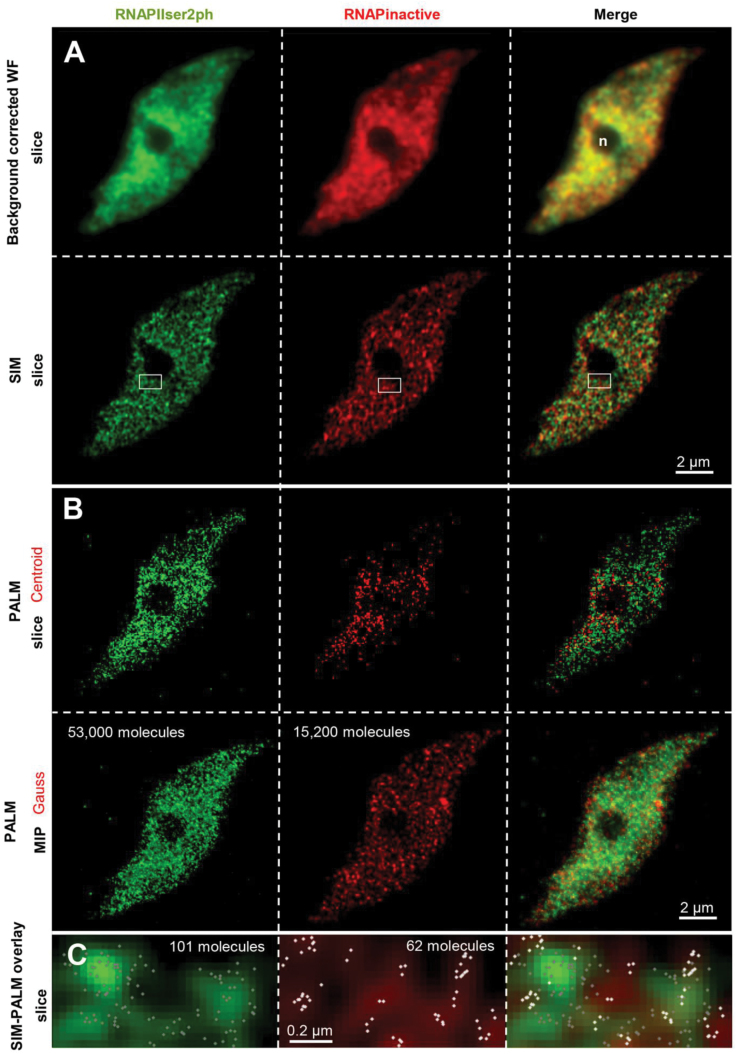
Distribution of inactive (not phosphorylated) and active (phosphorylated at Ser2) RNAPII molecules in an endopolyploid 8C A. thaliana leaf nucleus shown after applying background-corrected widefield (WF), SIM, and 3D-PALM. (A) In contrast to WF, SIM clearly shows that both RNAPII modifications form distinct intermingled reticulate structures within the nucleus which are absent from the nucleolus (n). (B) PALM reveals the number of RNAPII molecules (as centroids) in the same optical slice as shown in (A) (upper panel). The lower panel represents Gauss-rendered maximum intensity projections (MIPs) generated from all PALM slices to show the complete number of molecules evident in the nucleus. Thus the higher amount of active (53 000) compared with inactive (15 200) RNAPII molecules becomes obvious. (C) The overlay of the SIM (insets in A) and PALM image indicates the number and distribution of single RNAPII molecules within the structures resolved by SIM. The images show that both active and inactive molecules cluster in distinct regions of the nucleus.